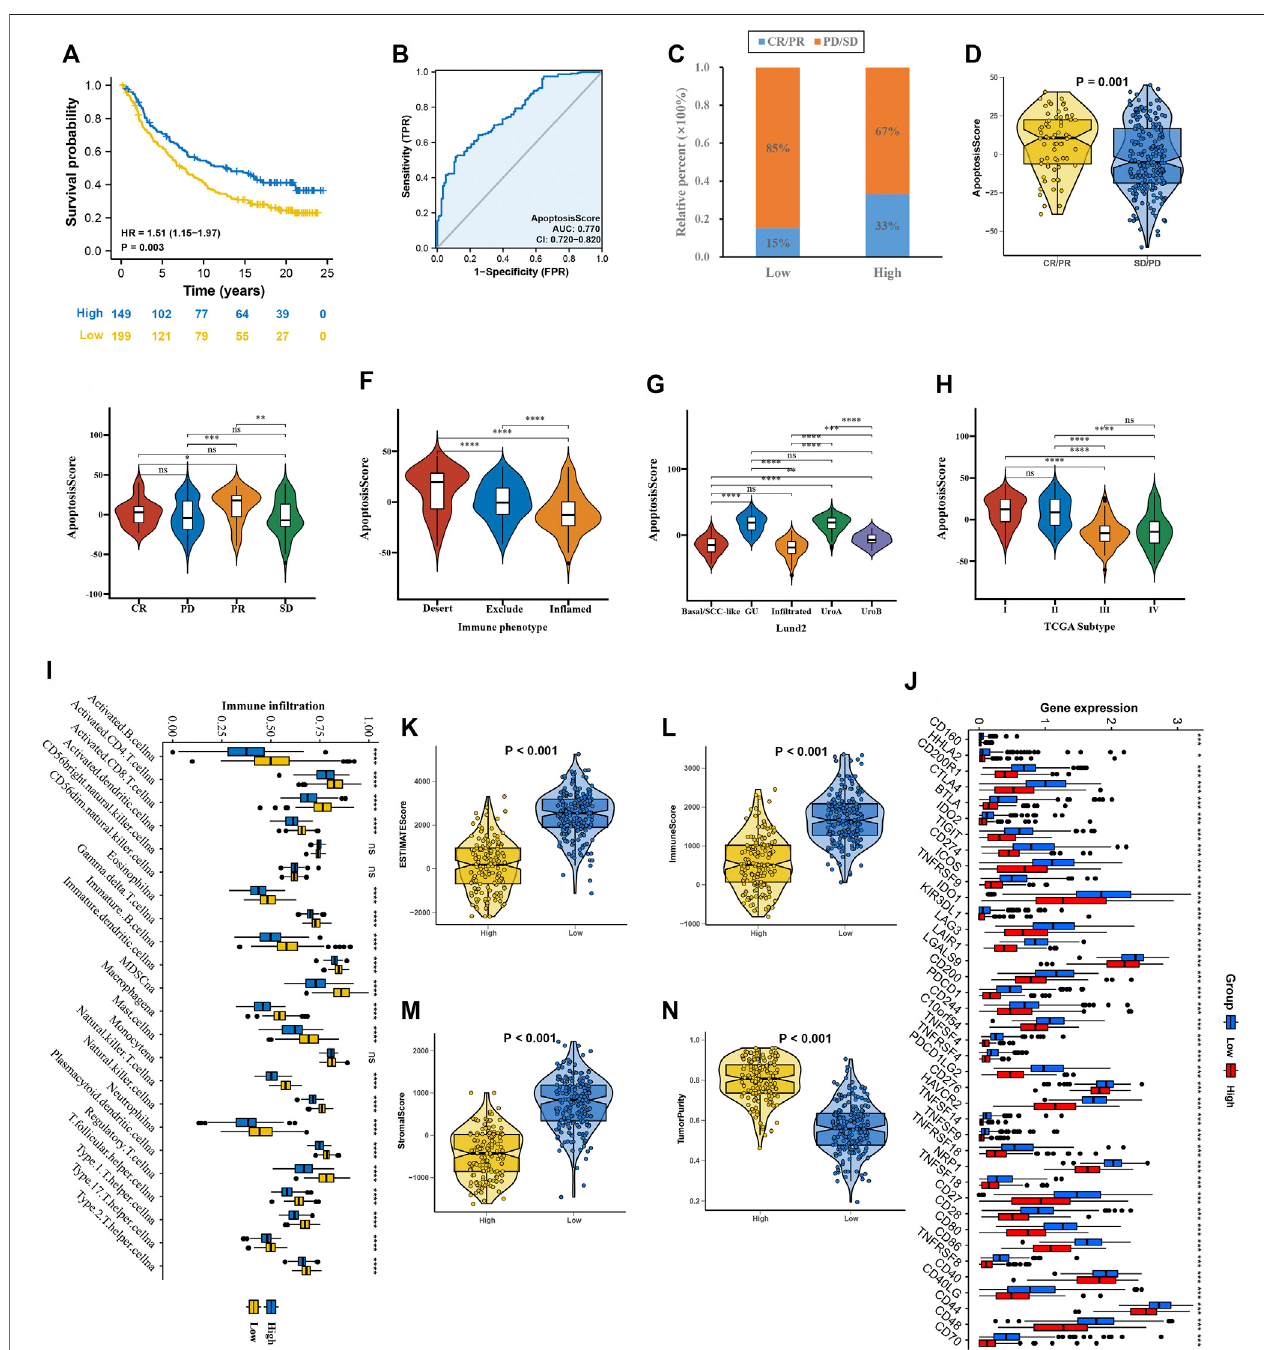
FIGURE 8 | ApoptosisScore in the role of anti-PD-1/L1 immunotherapy in IMvigor210 cohort. (A) Survival analyses for low and high apoptosisScore groups in IMvigor210cohort. (B) The predictivevalue ofapoptosisScore in IMvigor210 cohort. (C) The proportion ofpatients with response toPD-L1 blockade immunotherapy in low or high apoptosisScore groups. (D) Differences in apoptosisScore among distinct anti-PD-1 clinical response groups. (E) Distribution of apoptosisScore in distinct anti-PD-L1clinicalresponsegroups. (F – H) DifferencesinapoptosisScorebetweenimmunesubtypes,Lund2subtypes,andTCGAsubtypes. (I) Theabundanceof each TME in fi ltrating cell in high and low apoptosisScore groups. (J) Differences in checkpoint expression between low and high apoptosisScore groups. (K – N) The ESTIMATE score, stromal score, immune score, and tumor immunity levels in high and low apoptosisScore groups by using ESTIMATE algorithm.